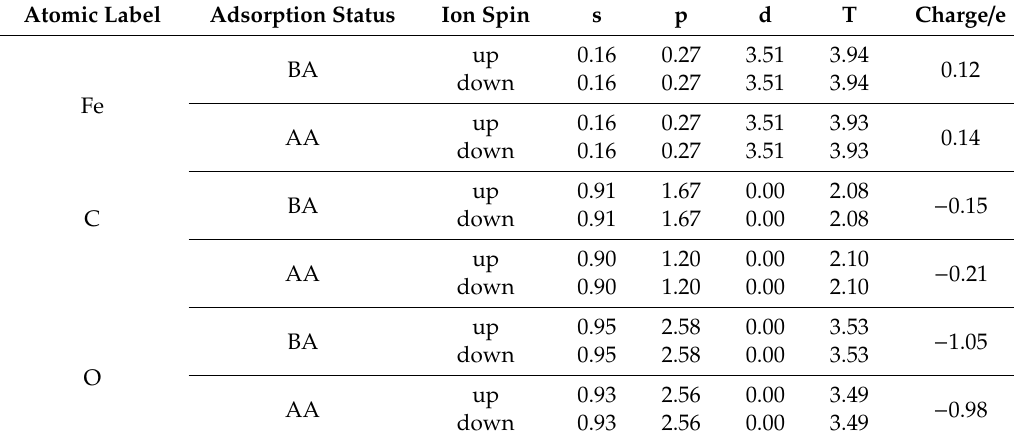
Table 5. Mulliken charge populations of atoms for H 2 O / AC.